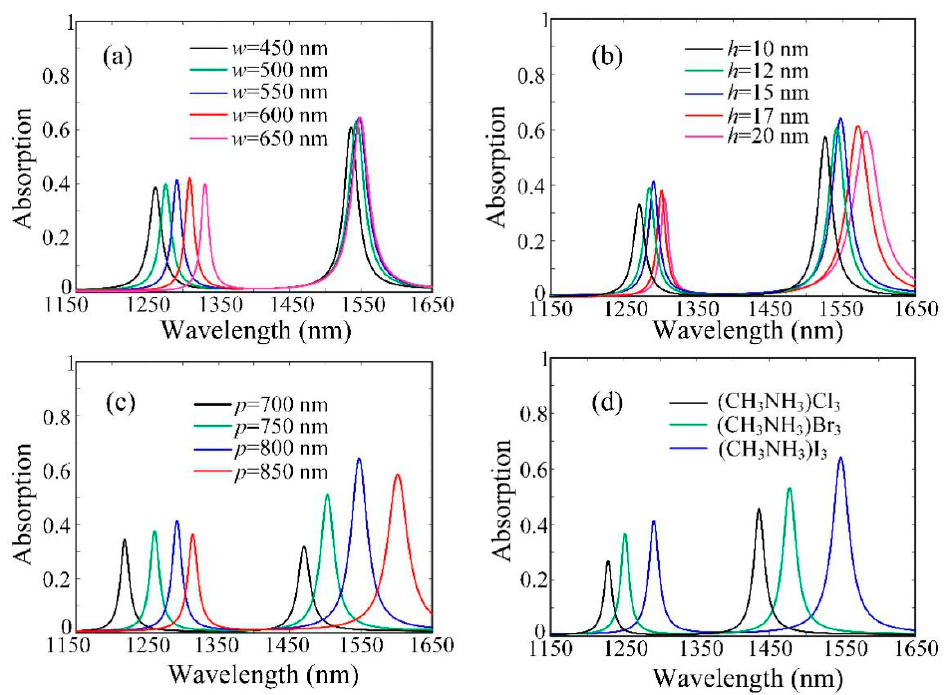
Figure 5. The absorption of (CH 3 NH 3 )PbI 3 layer under normal incident p -polarized light with different ( a ) widths w , ( b ) thicknesses h , and ( c ) periods P of silver strips, respectively. ( d ) Absorption spectra of different halide perovskites. The other parameters are the same as Figure 3.